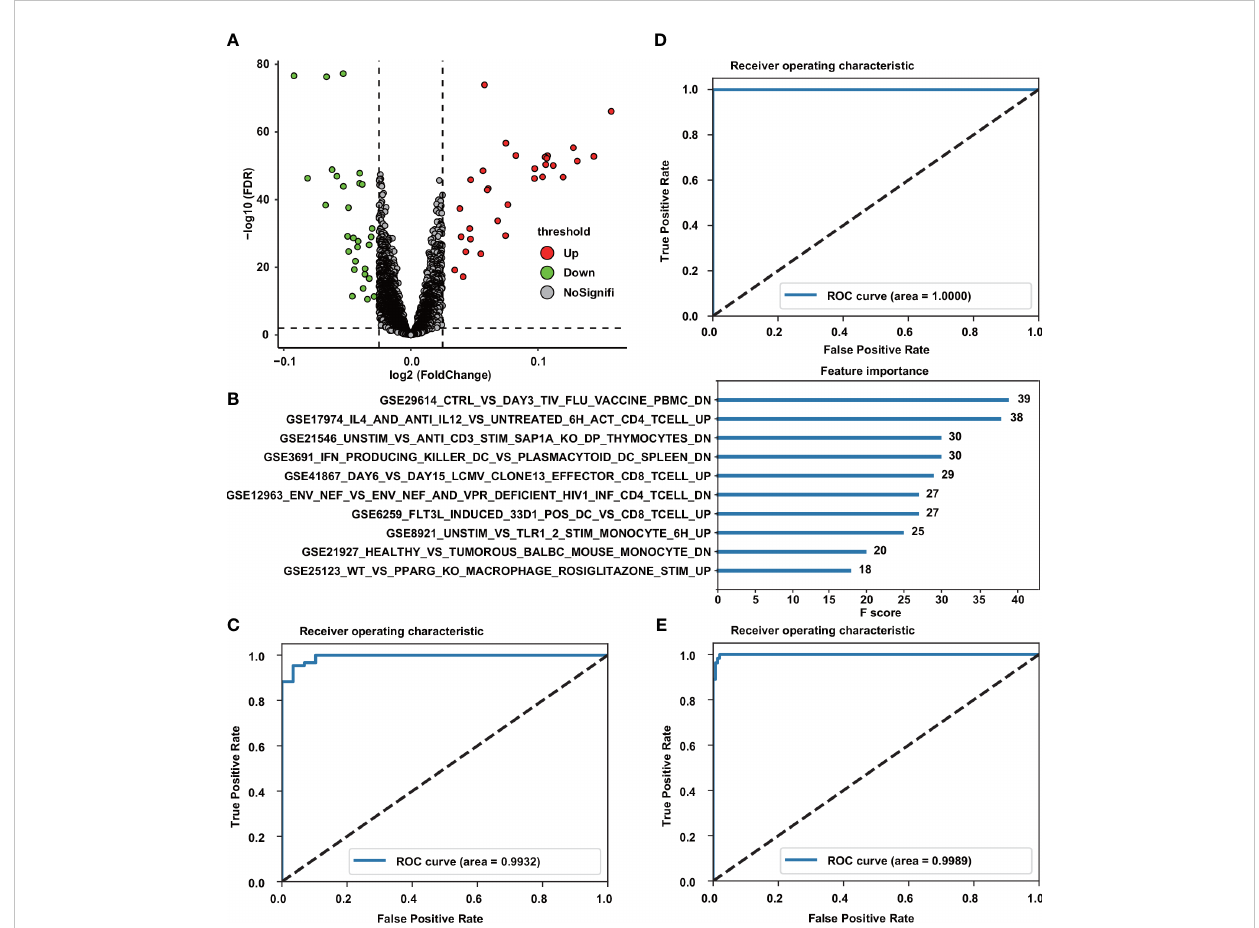
FIGURE 2 Construction of Diagnostic Model. (A) Volcano plot of differential analysis results between normal and cancer samples. Red, upregulated; green, downregulated. (B) Top10 feature importance in the diagnostic model. (C – E) ROC curves of the diagnostic model in the training cohort (C) , validation cohort (D) and the entire cohort (E)